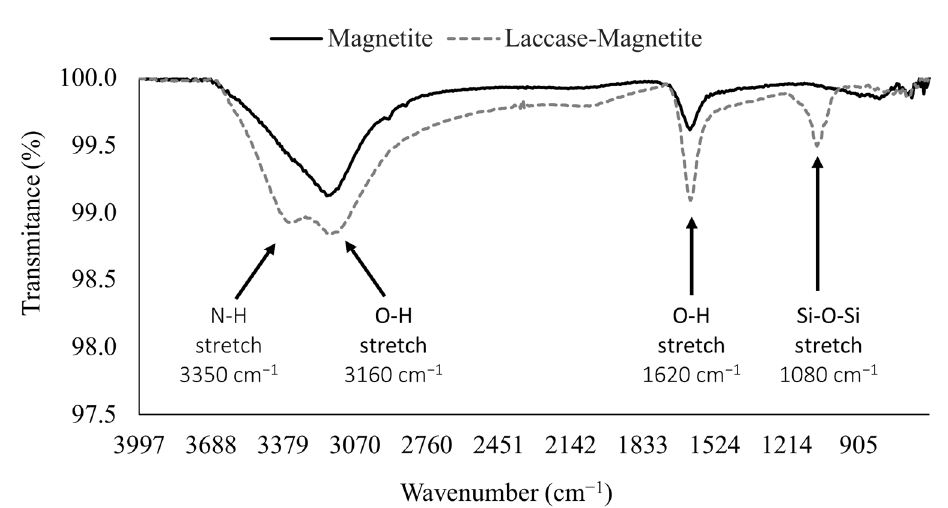
Figure 2. FTIR analysis of magnetite nanoparticles and laccase-magnetite nanobiocomposites, show- ing the identified peaks at 1080, 1620, 3160 and 3350 cm − 1 .